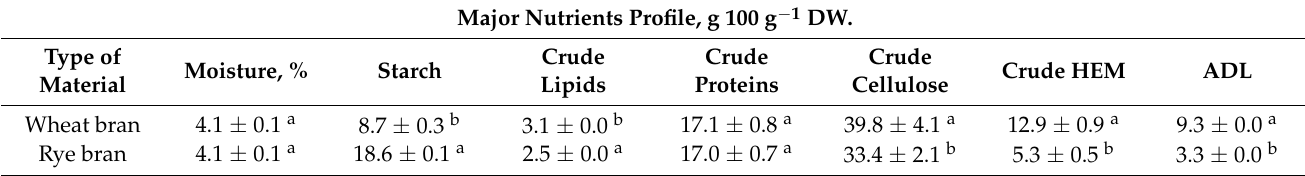
Table 1. Nutritional composition of bran by-products derived from wheat and rye grains, g 100 g − 1 DW. Major Nutrients Profile, g 100 g − 1